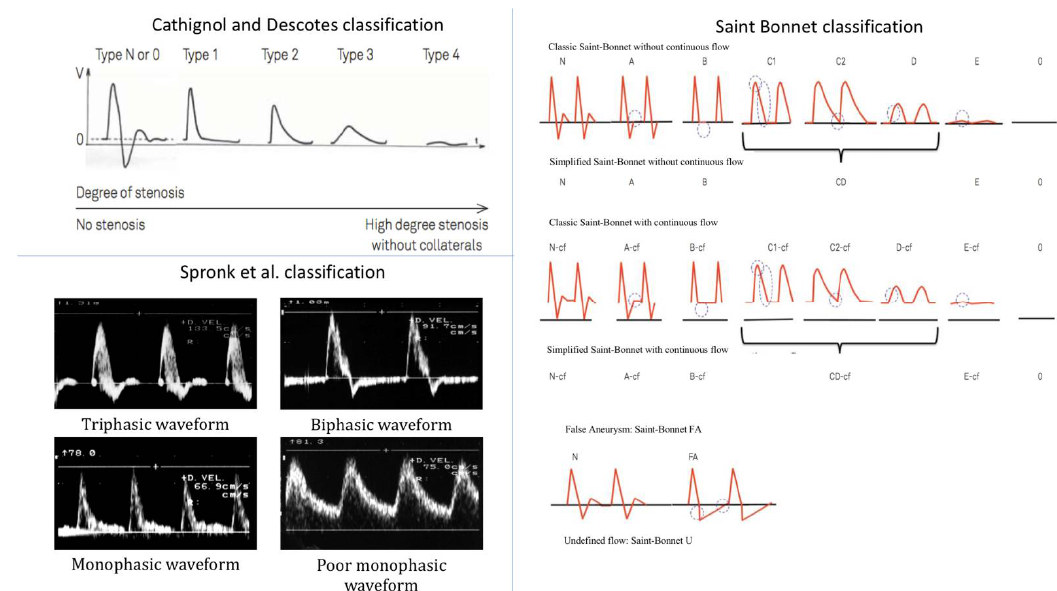
Figure 1. The different arterial Doppler waveform classifications. Panel labelled Cathignol and Descotes classification (adapted from [23]): Type N or 0 is considered as a normal waveform. Panel labelled Spronk et al. classification (adapted from [24]): Triphasic of biphasic types are considered normal. Monophasic and poor monophasic types describe different levels of peripheral artery disease (PAD), from the least to the highest degree. Panel labelled simplified Saint-Bonnet classification: Types N and A are considered normal. Types B to E describes different levels of PAD, from the least to the highest degree.